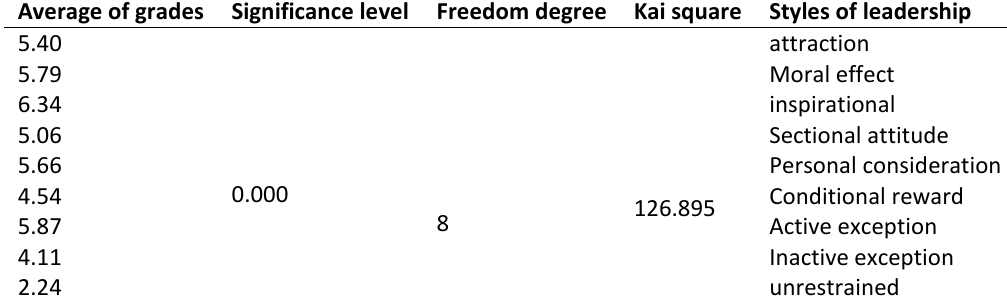
Table 6. Friedman test results, difference between coaches’ style of leadership.